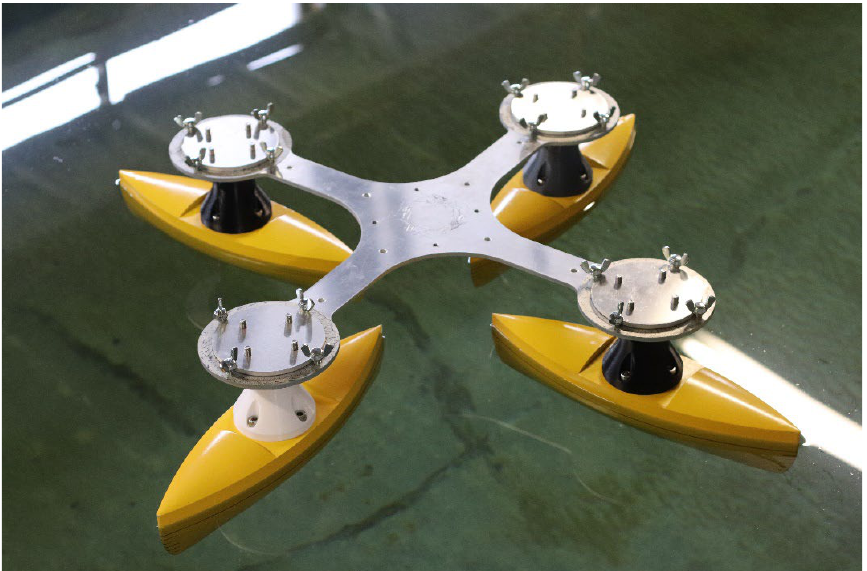
Figure 4. 1/3 scale model of a Quadmaran vessel.